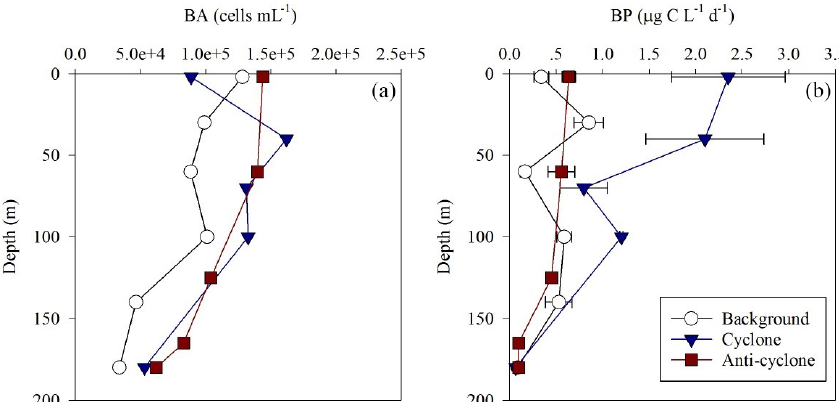
Figure 6. Vertical profile of heterotrophic bacterial abundance (a) and bacterial production rates (b) in the photic layer of cyclonic (blue triangle) and anticyclonic (red square) eddies and an uninfluenced background station (white circle) in the southeastern Mediterranean Sea during October